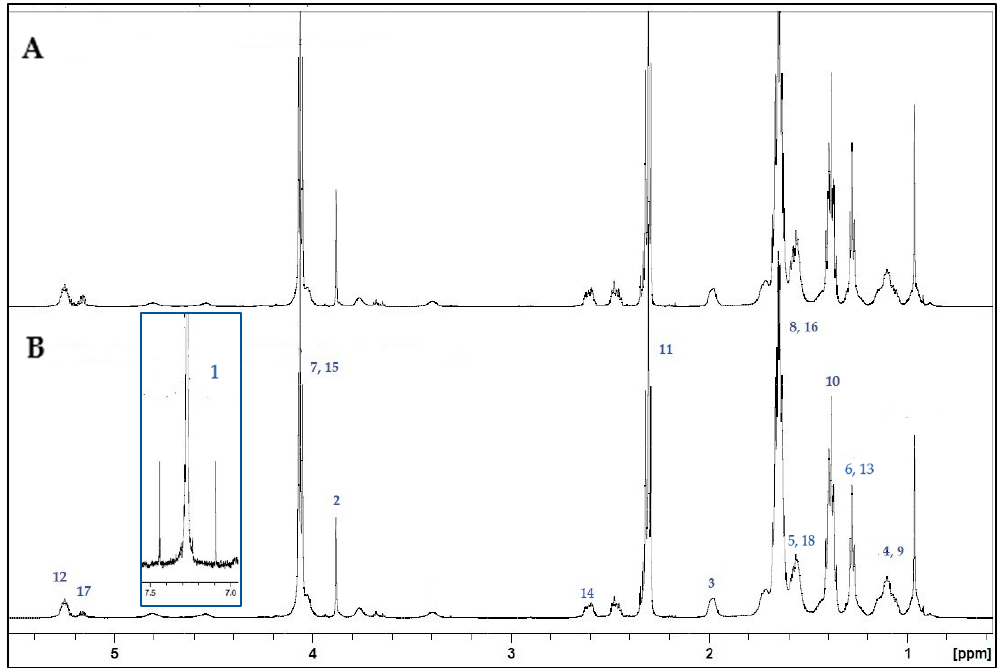
Figure 3. 1 HNMR spectra of PUR 20/5 + PLA: ( A ) before and ( B ) after 36 weeks of sample’s exposure to